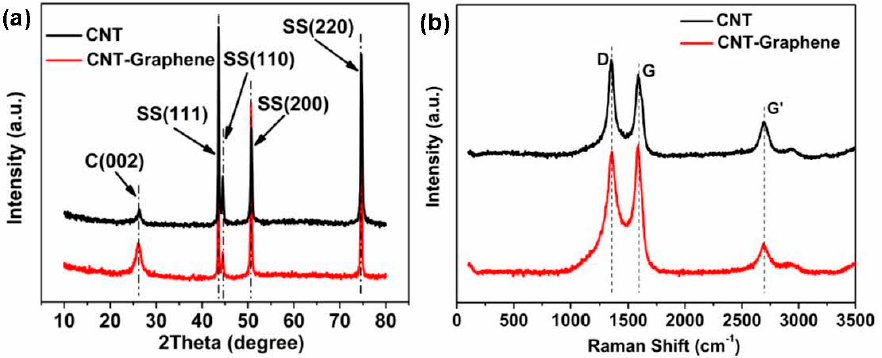
Figure 3. ( a ) XRD and ( b ) Raman results of the pristine CNTs and CNT-Graphene-0.1 hybrid.